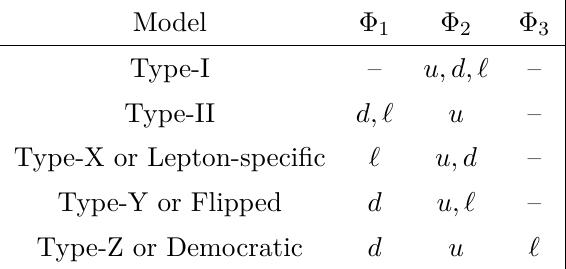
Table 1 . The five types of 3HDM subject to NFC. The table indicates which Higgs doublet is responsible for generating the mass of each type of fermion, wherein u ( d ) refers to an up(down)-type quark and ‘ to a (charged)